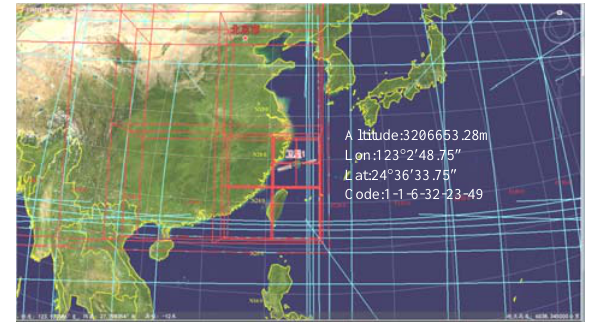
Figure 20. The e-Octree model grid and satellite’s position